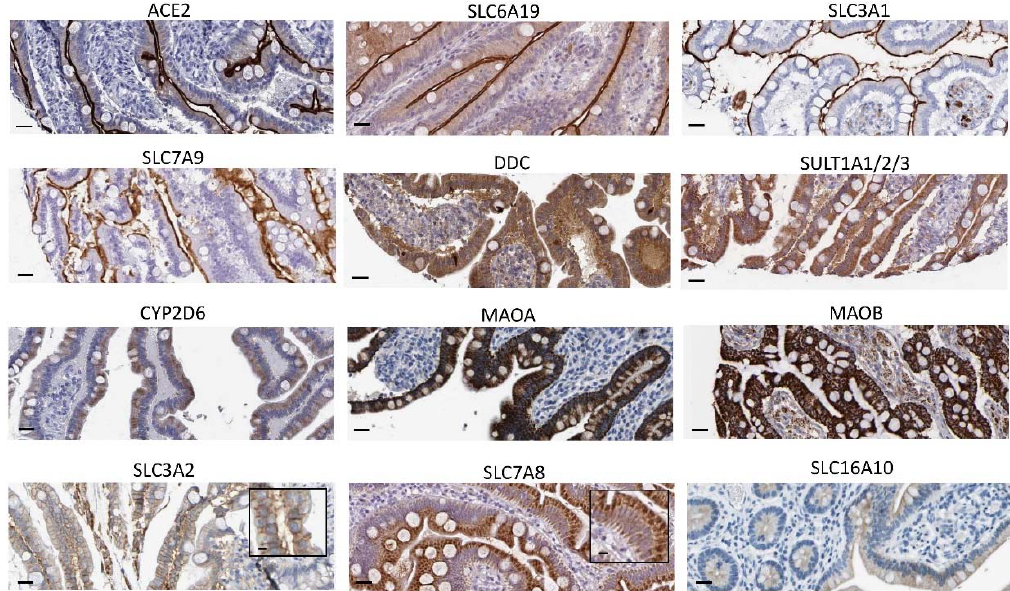
Figure 1. Expression by human enterocytes of key molecules involved in dopamine/trace amines metabolic pathways: A survey of the Human Protein Atlas (https://www.proteinatlas.org/ (accessed on 24 September 2021)) allowed extracting immunohistochemical data obtained on human small intestine for the following candidate molecules: angiotensin- converting enzyme 2 (ACE2), solute carrier family 6 member 19 (SLC6A19), solute carrier family 3 member 1 (SLC3A1), solute carrier family 7 member 9 (SLC7A9), dopa-decarboxylase (DDC), sulfotransferase family 1A member 1 (SULT1A1), sulfotransferase family 1A member 2 (SULT1A2), sulfotransferase family 1A member 3 (SULT1A3), cytochrome P450 family 2 subfamily D member 6 (CYP2D6), monoamine oxidase A (MAOA), monoamine oxidase B (MAOB), solute carrier family 3 member 2 (SLC3A2), solute carrier family 7 member 8 (SLC7A8) and solute carrier family 6 member 10 (SLC16A10). Scale bar: 25 µ